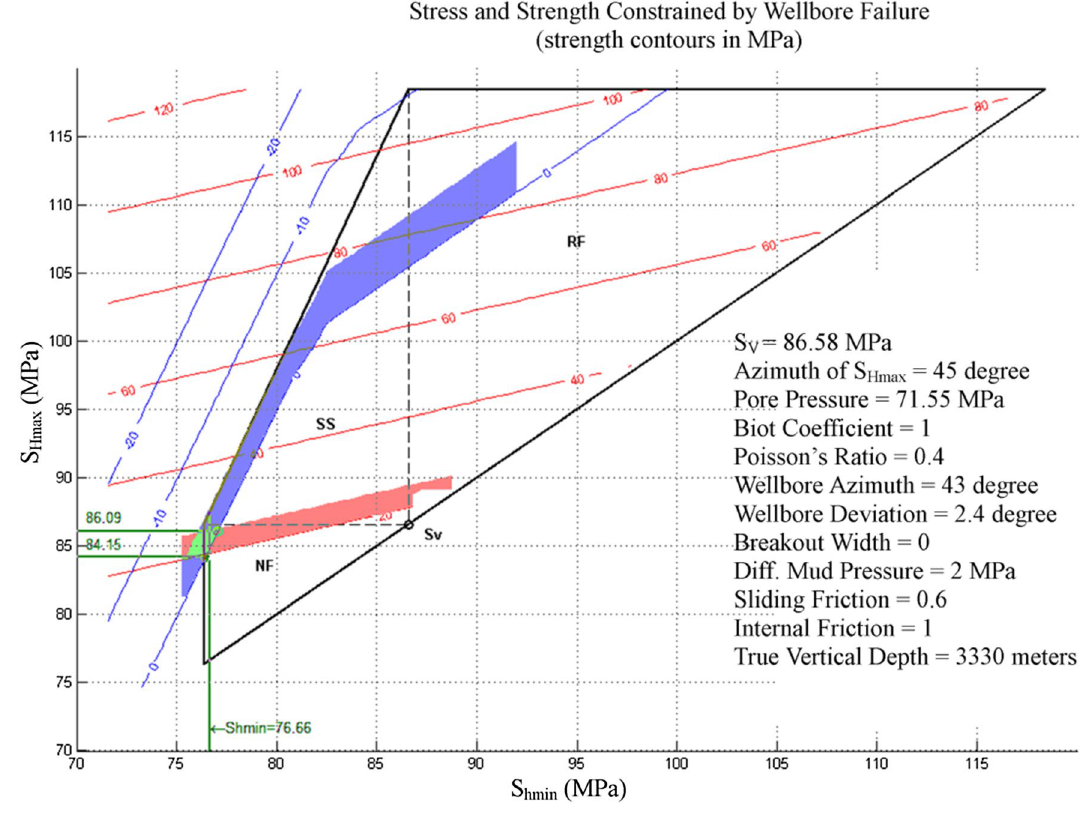
Fig. 3 Stress polygon based on the Mohr–Coulomb failure criterion for Marun 133